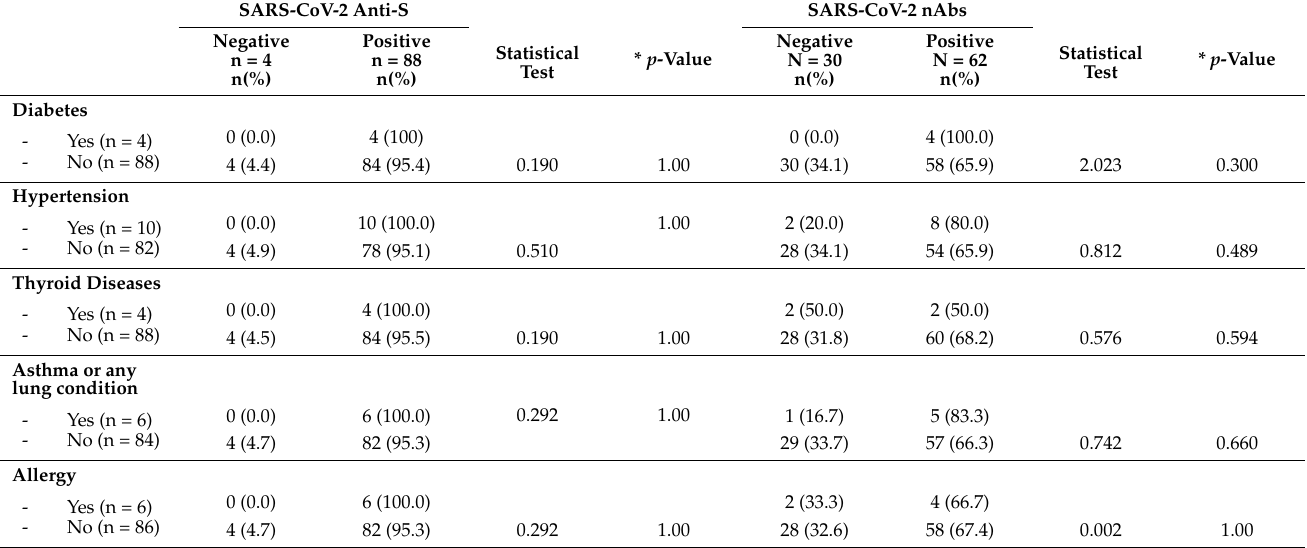
Table 7. Association between the seroprevalence of SARS-CoV-2 anti-S and nAbs in relation to the medical history of 92 Sinopharm vaccine recipients.